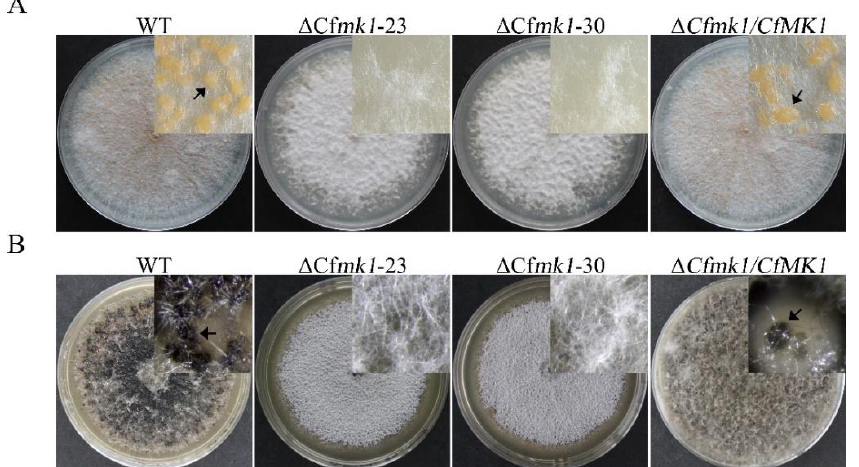
Figure 2. Defects of the Cfmk1 mutant in asexual and sexual reproduction. ( A ) Conidiation of the WT, Δ Cfmk1-23 , Δ Cfmk1-30 , and Δ Cfmk1 / CfMK1 after growth on CM plates for 10 days. Conidial masses are marked with arrows. ( B ) Three-week-old mating cultures of the same set of strains. Perithecia are marked with arrows.